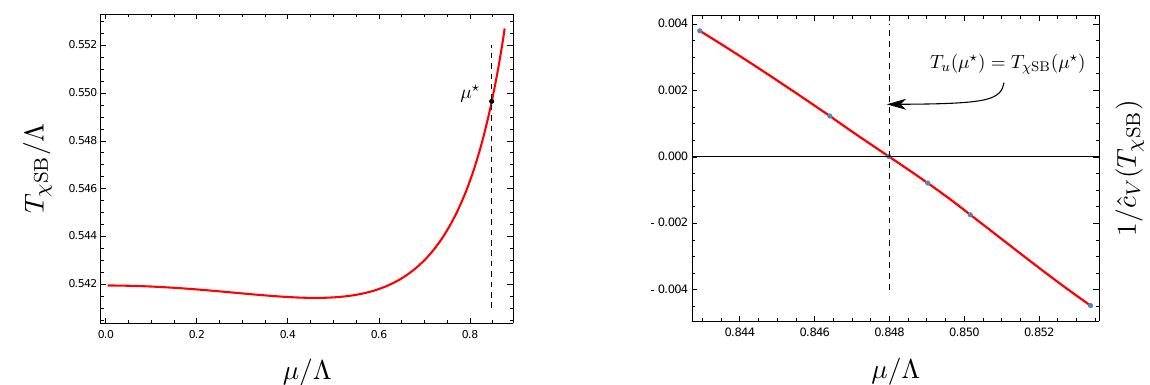
Figure 27 . Left panel: the critical temperature T χ SB of the spontaneous chiral symmetry breaking s in states, i.e., the Klebanov-Tseytlin black holes, as a function of µ/ Λ. Right panel: µ ∗ , decon T see (6.15), identifies the S 3 compactification scale µ with the divergent reduced specific heat ˆ c V at T χ SB ( µ ∗ ). At µ = µ ⋆ the critical temperature T χ SB coincides with the terminal temperature T u of s decon T